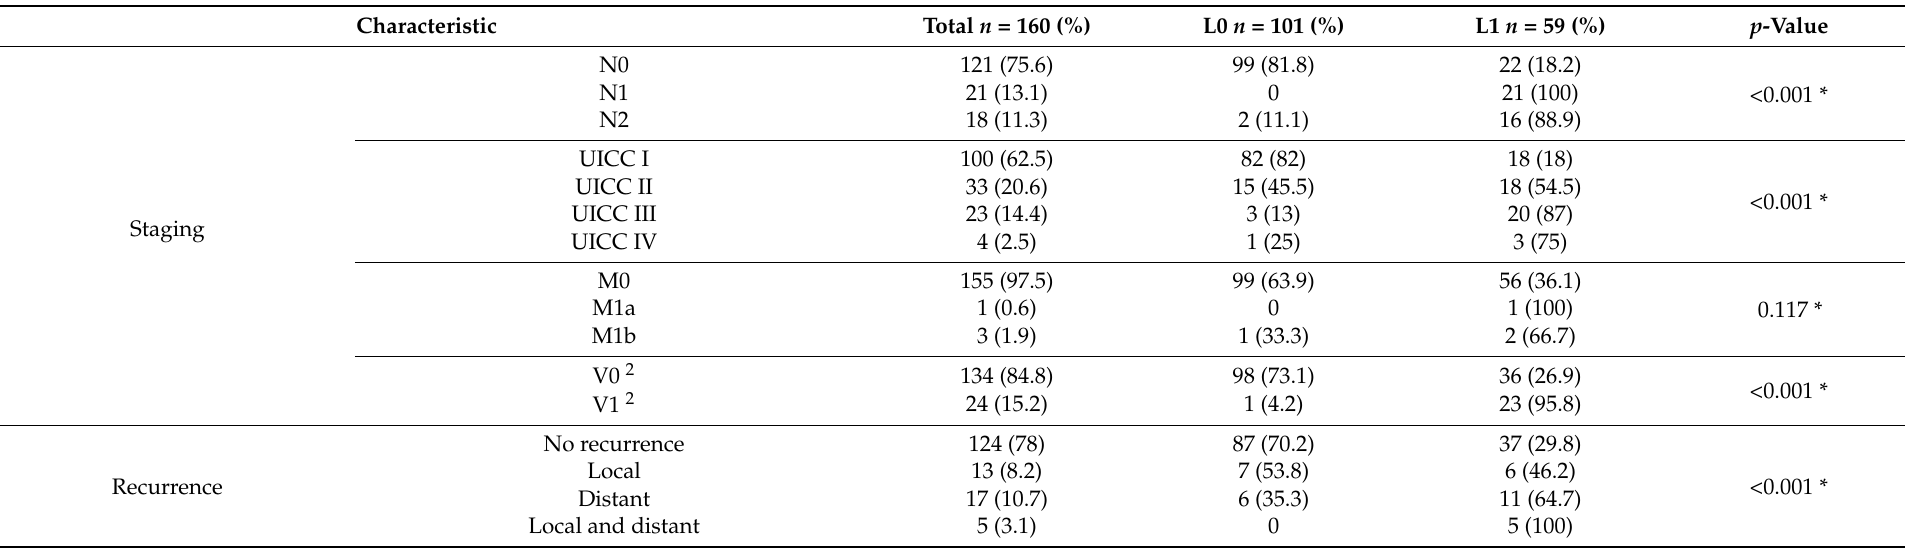
Table 2. Association of lymph vessel invasion with the patients’ clinicopathological parameters ( n =